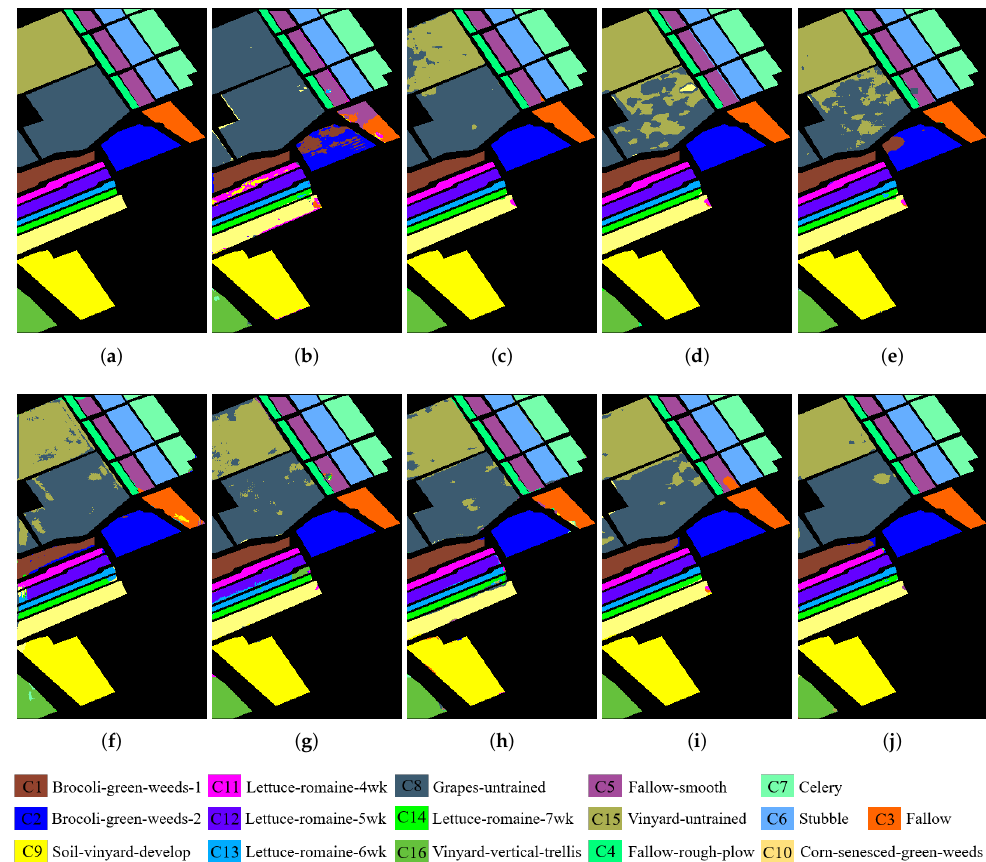
Figure 8. Map of the classification results from all approaches on SV. ( a ) Ground truth. ( b ) CD-